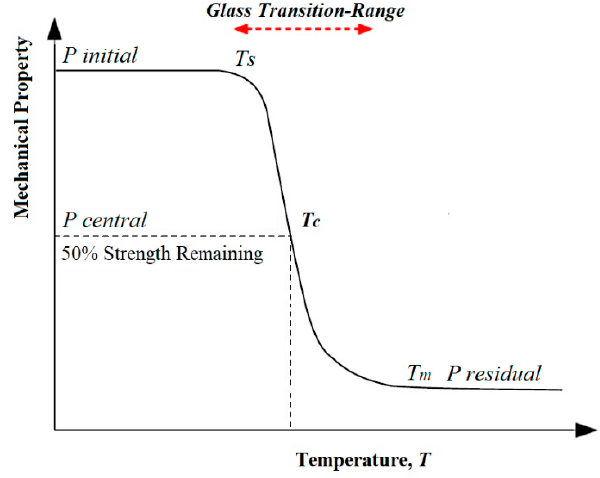
Figure 1. Idealised relationship between FRP mechanical properties and temperature [32].